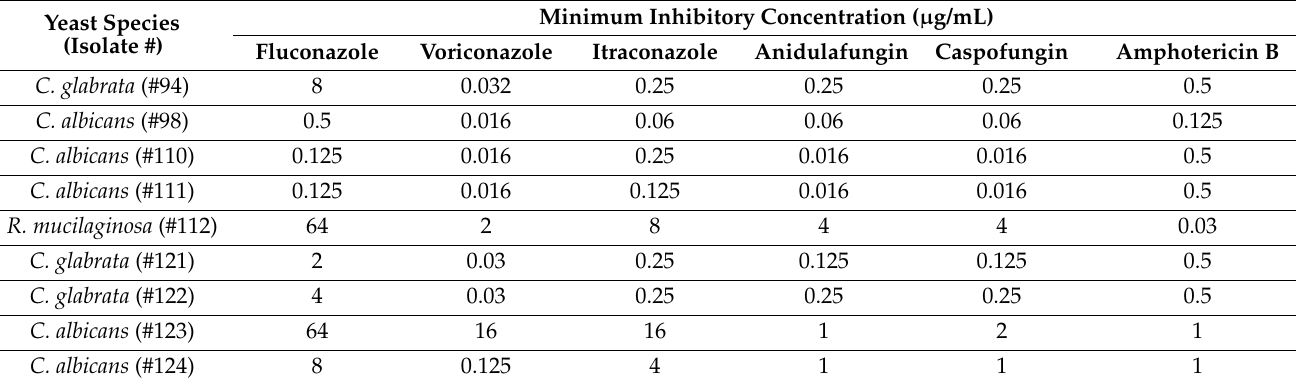
Table 2. Antifungal susceptibility profiles of yeasts recovered from patients with COVID-19-associated fungemia. Yeast Species (Isolate